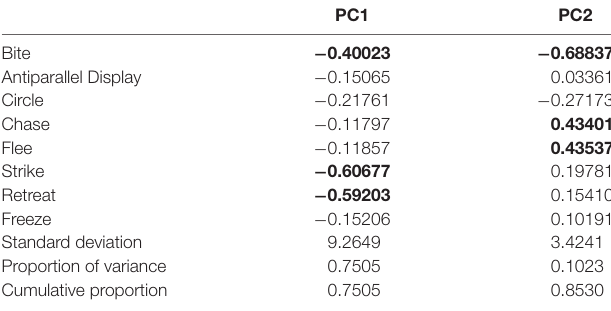
TABLE 2 | Summary of principal components analysis (PCA) on behavioral